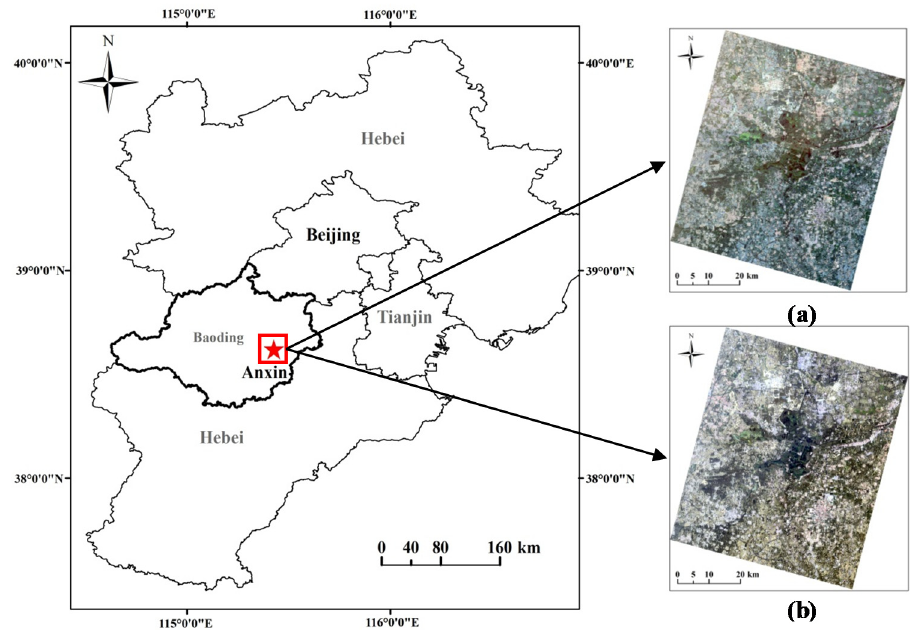
Figure 2. Location of study area. ( a ) hyperspectral image; ( b ) multispectral image.